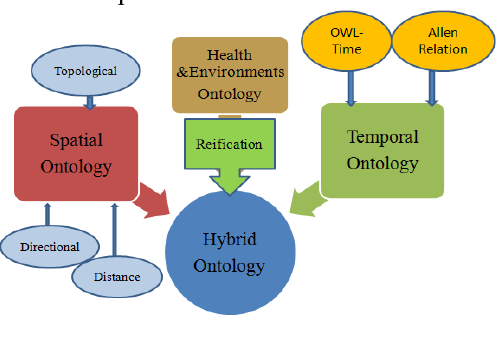
Figure 1.Proposed hybrid model.